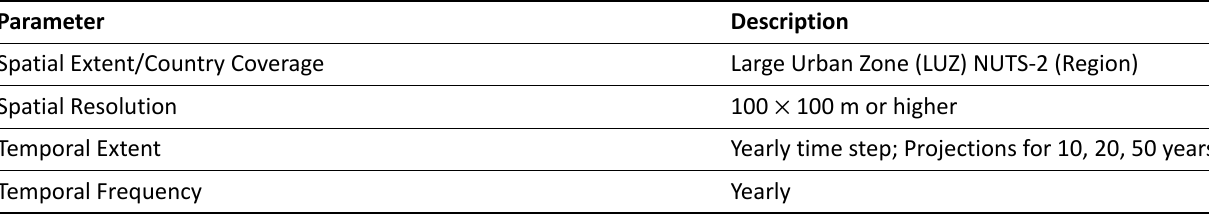
Table 2. Spatio-temporal extent and resolution of the model